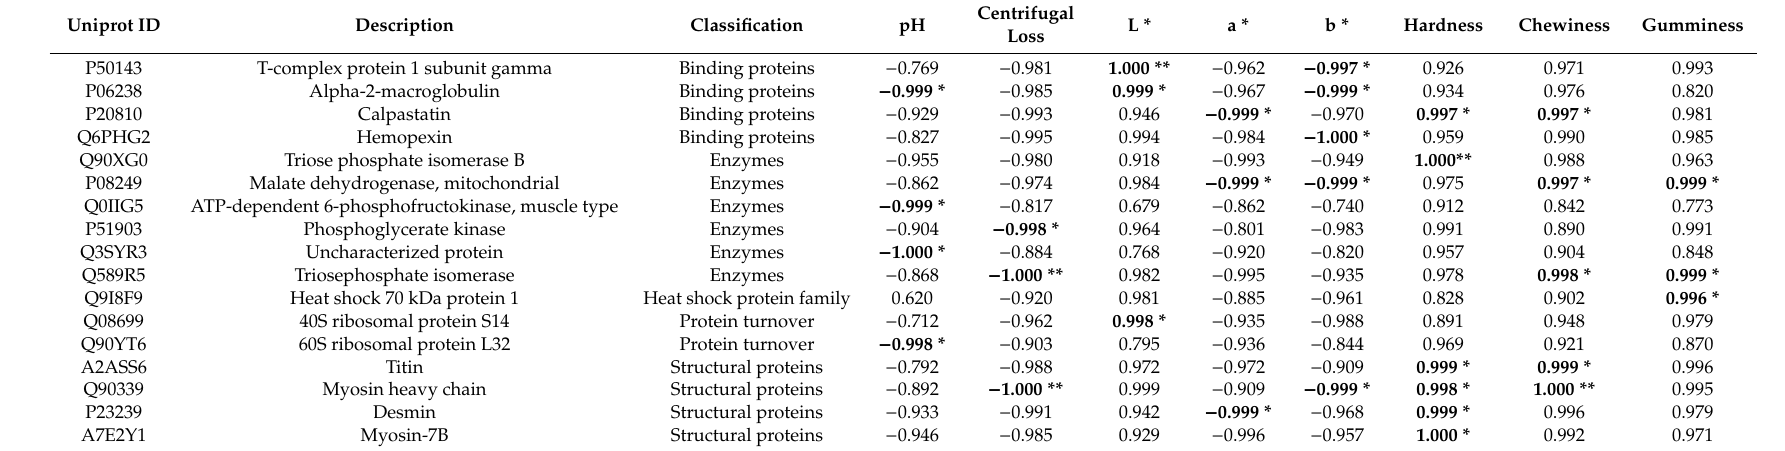
Table 2. Pearson correlation between di ff erentially significant expressed proteins (DSEPs) and quality indicators of grouper fillets during refrigerated storage (Days 0, 6, and 12) at 4 ◦ C ( p <